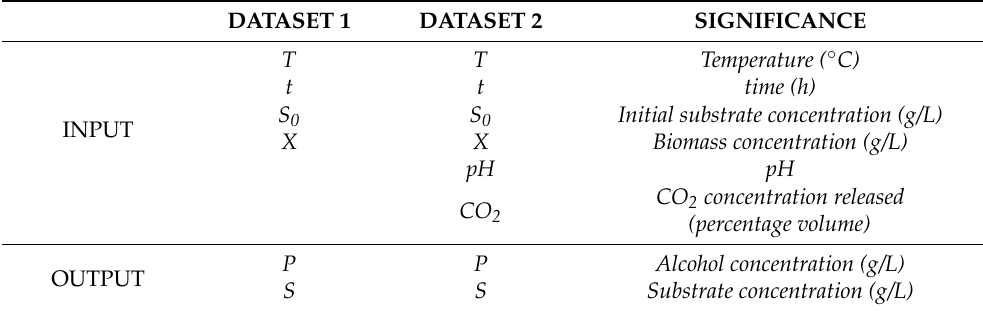
Table 1. Data sets used for training and testing the NN (in and out